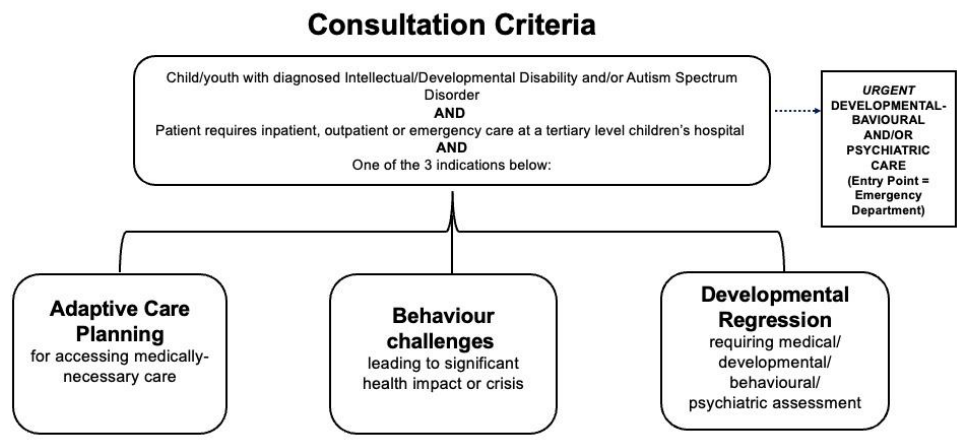
Figure 1. Developmental-behavioral and mental health tertiary children’s hospital service consulta- tion criteria and clinical pathways.